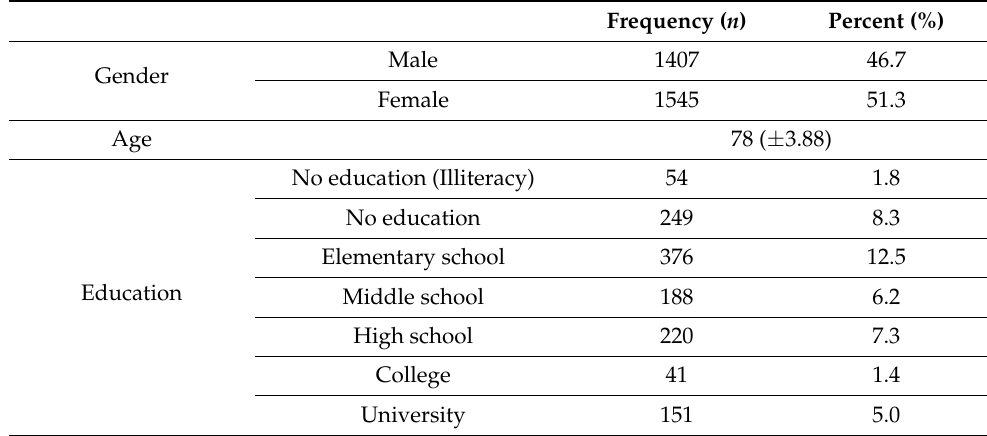
Table 1. General information about subjects used as control